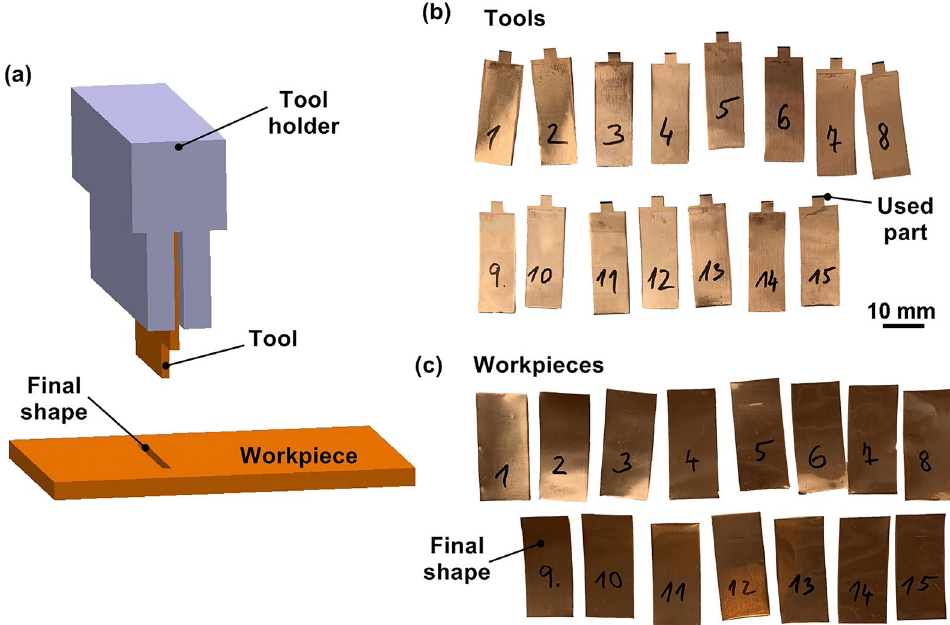
Figure 1. Description of the performed experiment with individual tools and workpieces ( a ) schematic representation of the experiment (created in program SolodWorks-www. solid works. com), ( b ) tool electrodes used, ( c ) workpieces with eroded final slot shape.